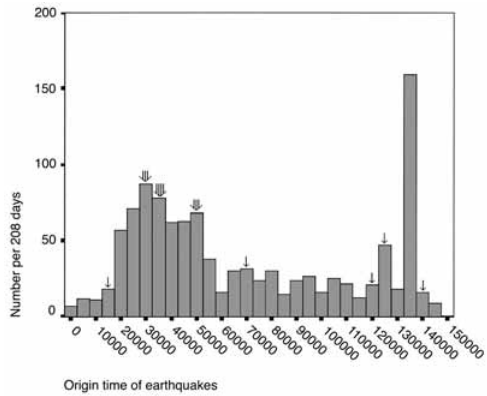
Fig. 3. Time history of seismic activity during the period 1983-1999 given in number of shocks per 208 days. Arrows indicate the occurrence of one or more earthquakes with magnitude M (cid:42) 4.